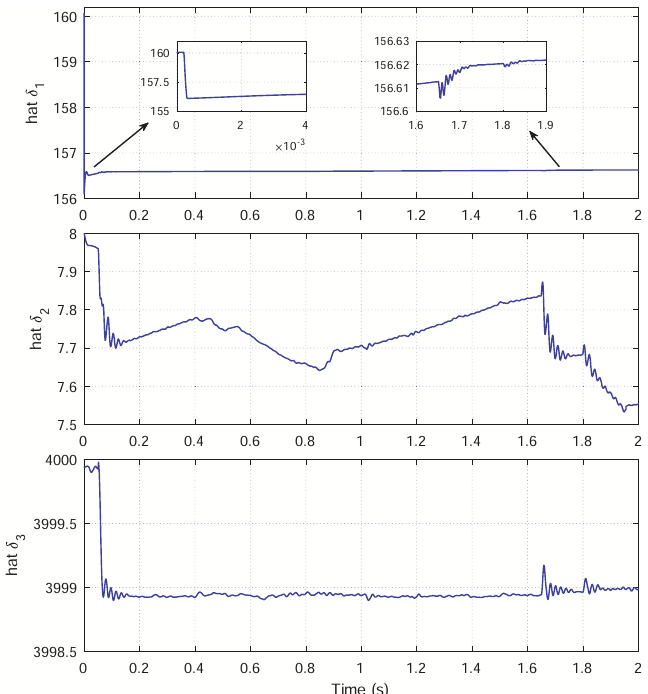
Figure 8. Adaptive estimation of system parameters.